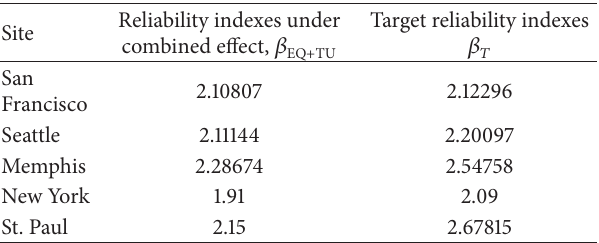
Table 7: Reliability indexes for the shearing limit state under combined seismic and thermal